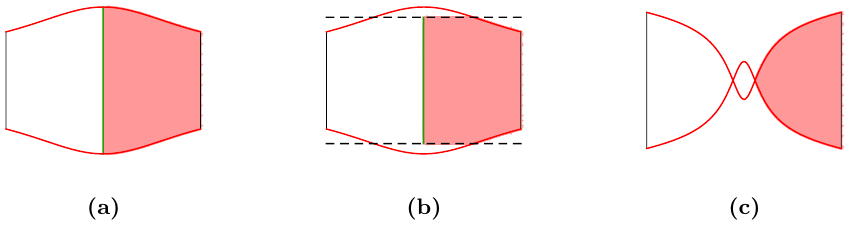
Figure 13. Slicings of disk brane configurations used in the computation of their Euclidean on- shell actions. We identify u with the angular ( φ ) direction in (3.14). Note that the central r = 0 line (which is the position of the conical defect) is a horizon in this